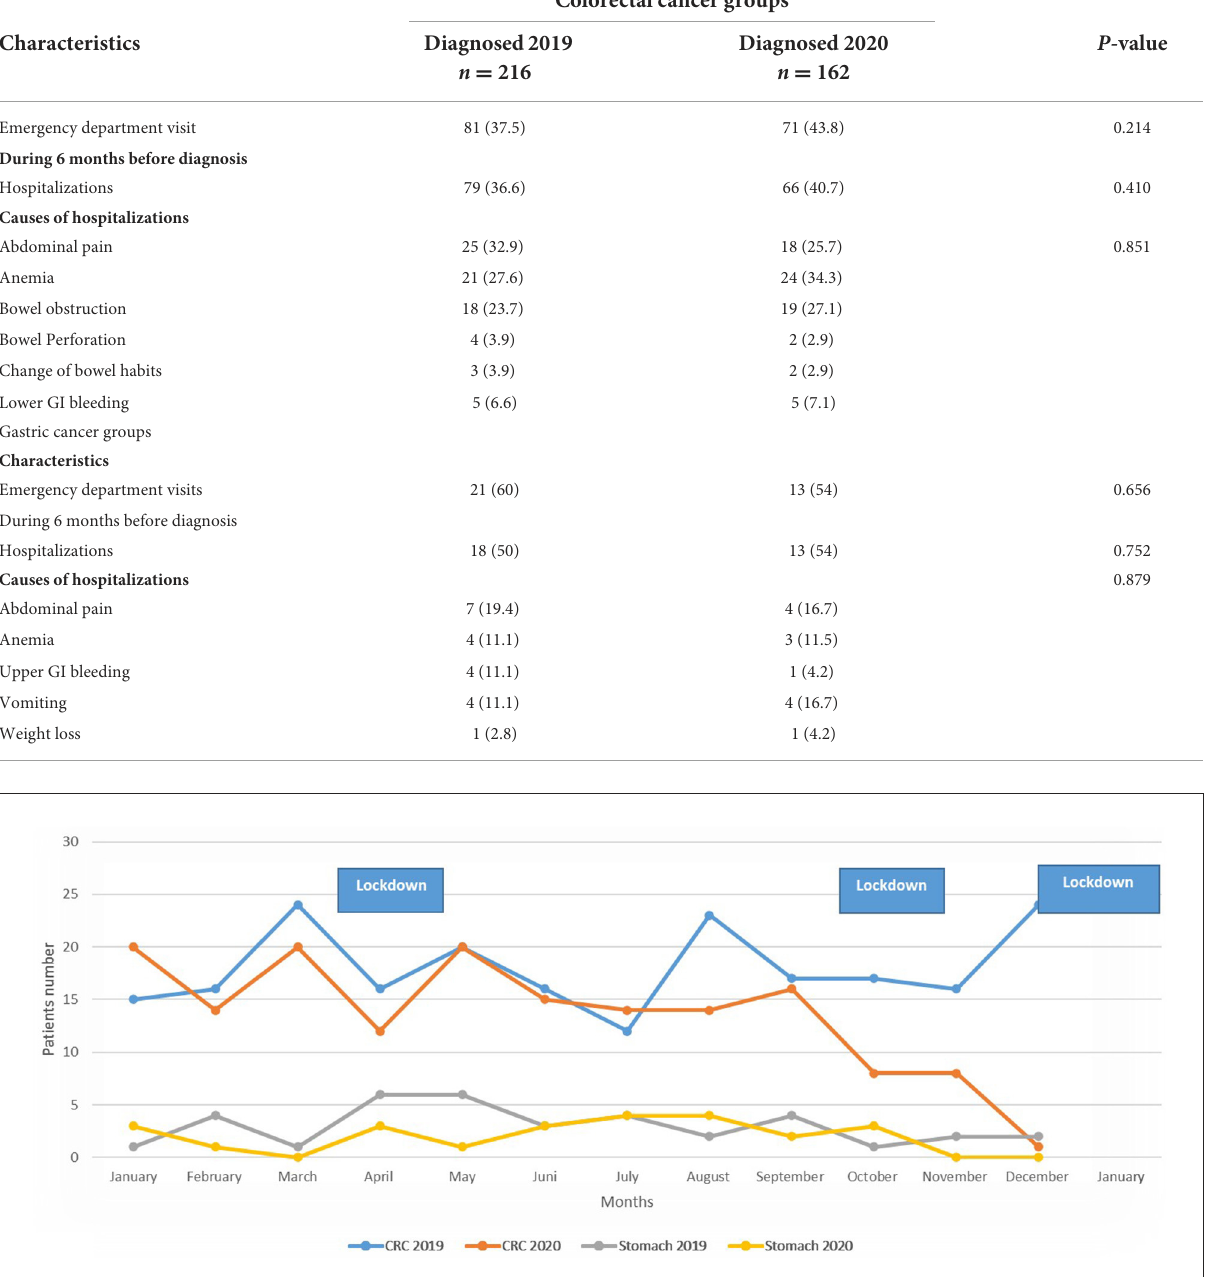
TABLE 3 Emergency department visits and hospitalizations among the study groups.